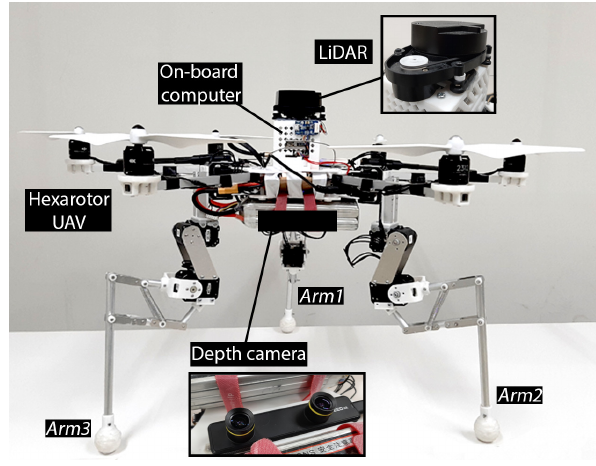
Figure 3. UAV with parallel link three-manipulator system.